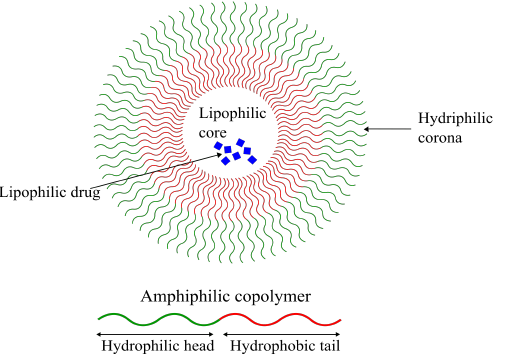
Figure 6. Schematic representation of a polymeric micelle formed by an amphiphilic polymer with a lipophilic drug encapsulated in its lipophilic core. Hydrophilic drugs can also be encapsulated in polymeric micelles due to their amphiphilic